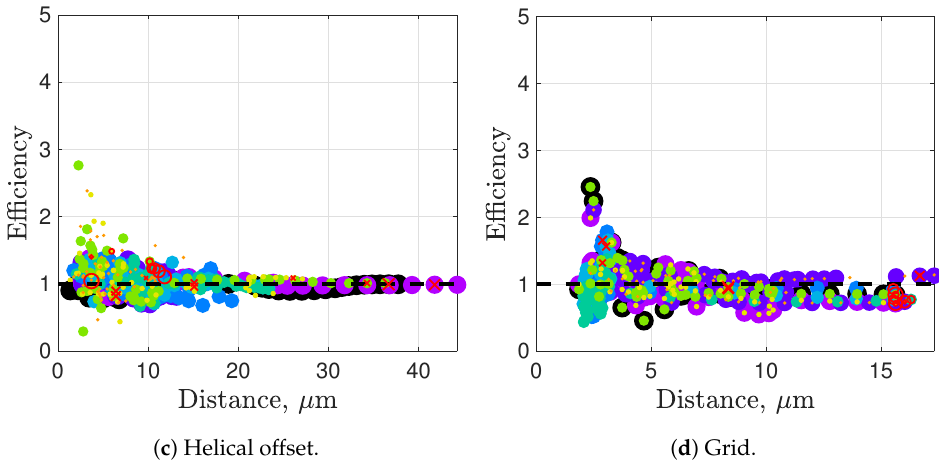
Figure 11. Efficiency normalized to a single swimmer in free space (dotted horizontal line), plotted with respect to minimal distance (in µ m) to other flagella. Each dot represents one flagella (corre- sponding to its color as depicted in Figure 4) for one beat. Dot size is used to effectively show overlap of data only and does not indicate any other metric. For reference, red circles denote initial beat and red x’s denotes final beat for each flagella, with label size varied to show